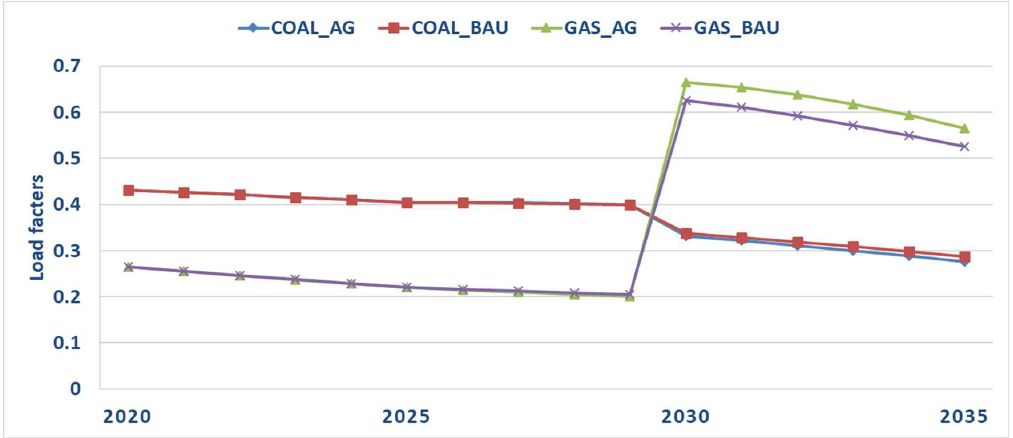
Figure 3. Load factors for the technologies of coal and gas under the BAU and AG demand response